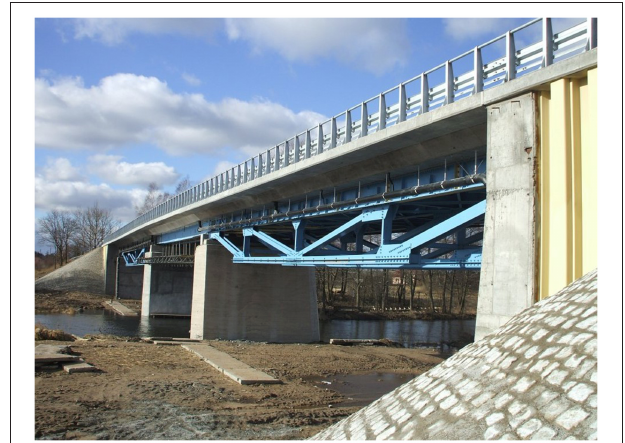
FIGURE 3 | The road bridge view—the extreme span at the foreground; from Olaszek (2015) permission was granted by The Committee on Civil Engineering and Hydroengineering of the Polish Academy of